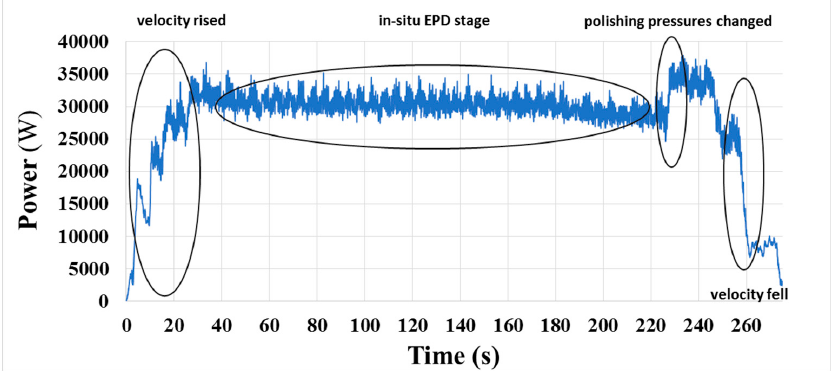
Figure 5. Original motor power signal of the polishing platen drive during a CMP process.